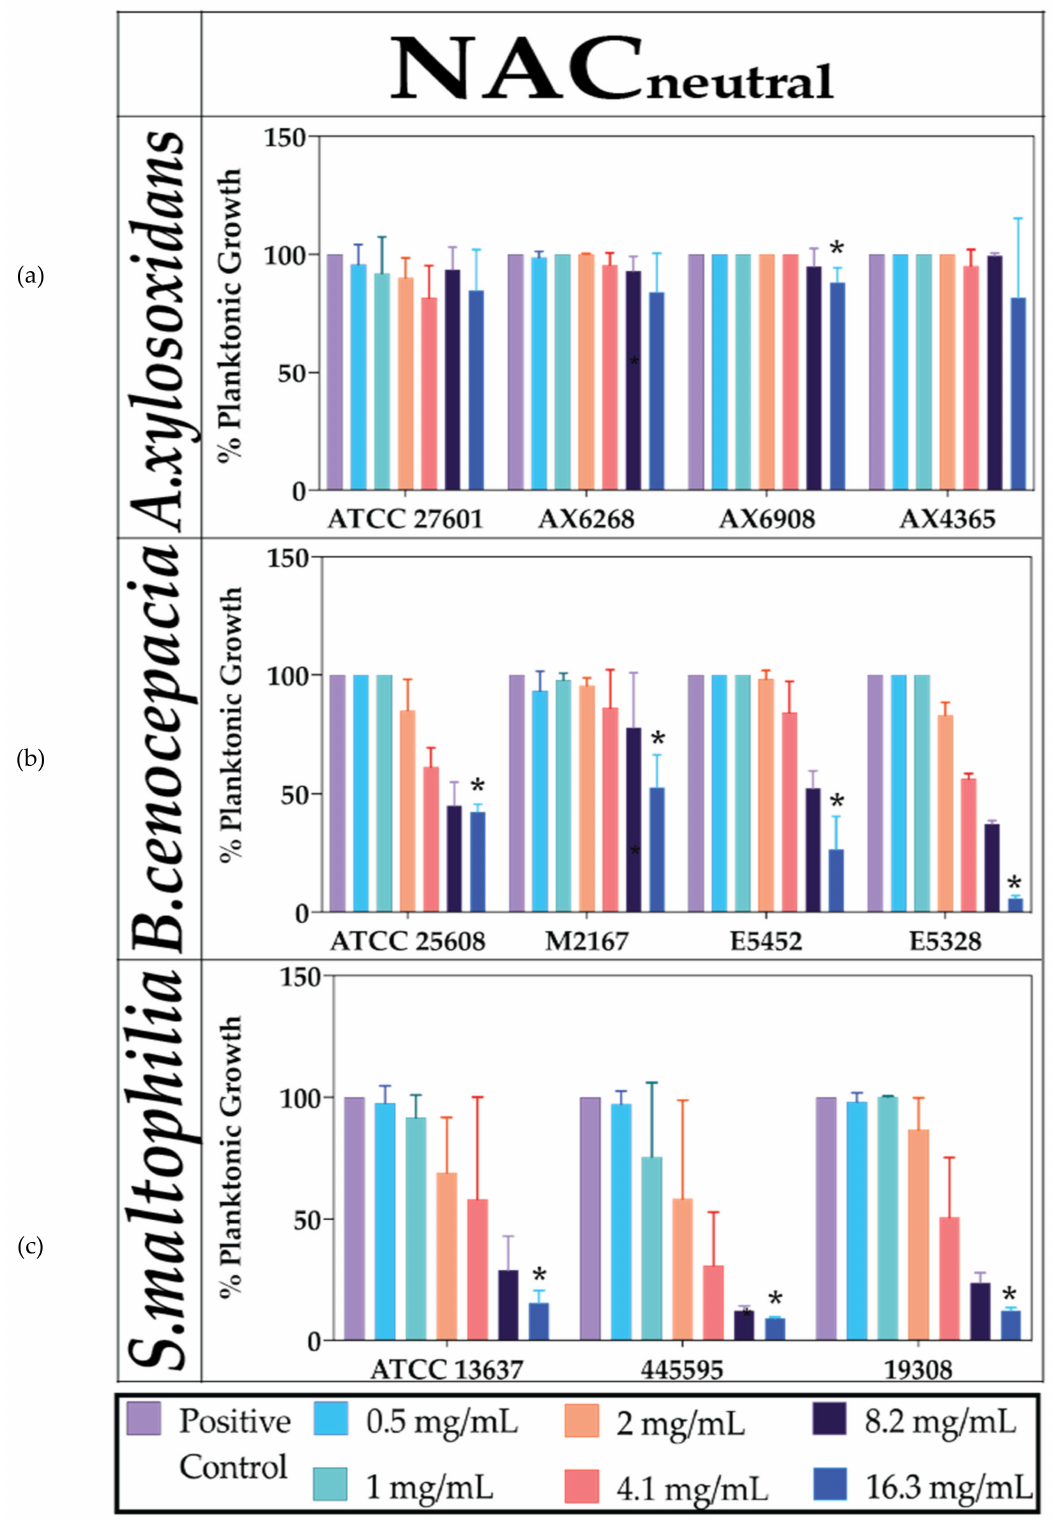
Figure 1. The effect of neutralised NAC alone on planktonic bacterial growth. Concentration-dependent effect of NAC neutral on percentage planktonic growth of ( a ) B. cenocepacia ( b ) A. xylosoxidans and ( c ) S. maltophilia strains. Statistical analyses were performed using unpaired Student’s t -tests (with Welch’s correction) and multiple comparison tests (Kruskal–Wallis test with Dunn’s correction). Significance cut-offs are as follows p ≤ 0.05 ( * ). Data represent an average of n = 3 biological